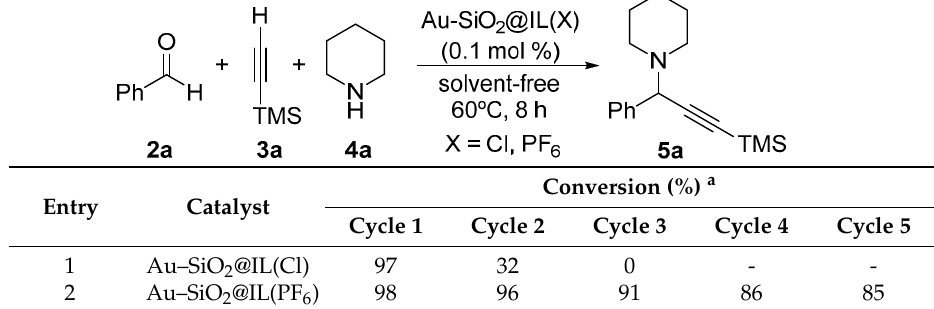
Table 4. A 3 coupling reaction catalyzed by Au–SiO 2 @IL and the recycling of the catalyst.